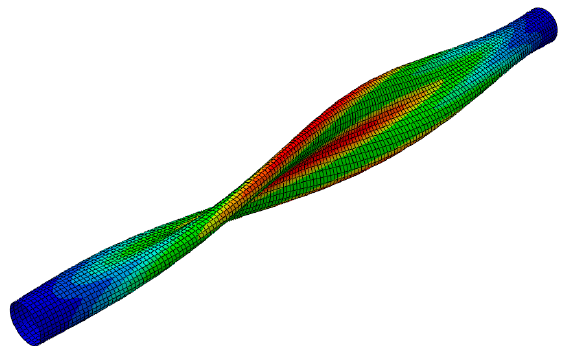
Figure 7. First buckling mode shape of a hybrid composite driveshaft, stacked as [±45° glass /0° carbon /90° glass ], computed for length = 1730 mm, radius = 50.8 mm, and wall thickness = 2.032 mm. To detect the deformation and critical buckling load, eigenvalue buckling analysis was conducted, where the model was fully fixed at one end and subjected to torsion load at the other end. The corresponding buckling torque value from Equation (33) was 2149 N·m and from FEA was 1730 N·m.